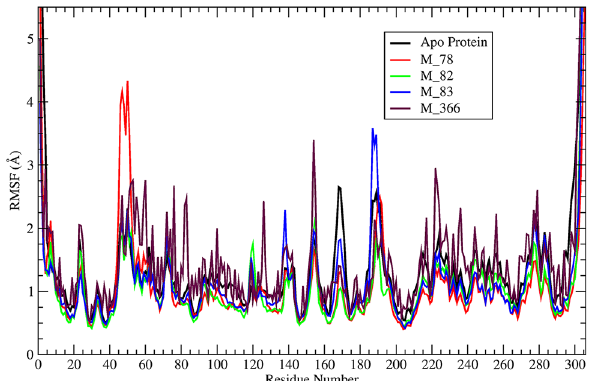
Figure 3. A visual representation of M pro backbone RMSF vs residue number of M pro –ligand (M_78, M_82, M_83, M_366) systems and apo-protein during 100 ns simulation.